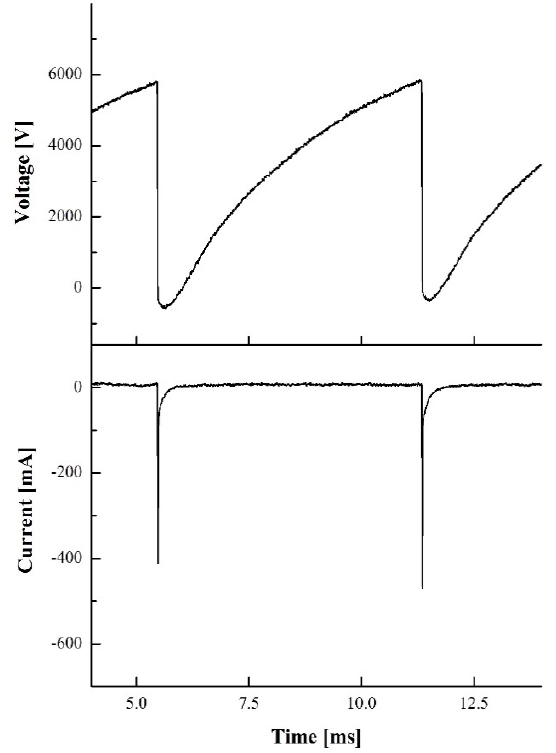
Figure 6. The current and the voltage waveforms for CCL power supply.